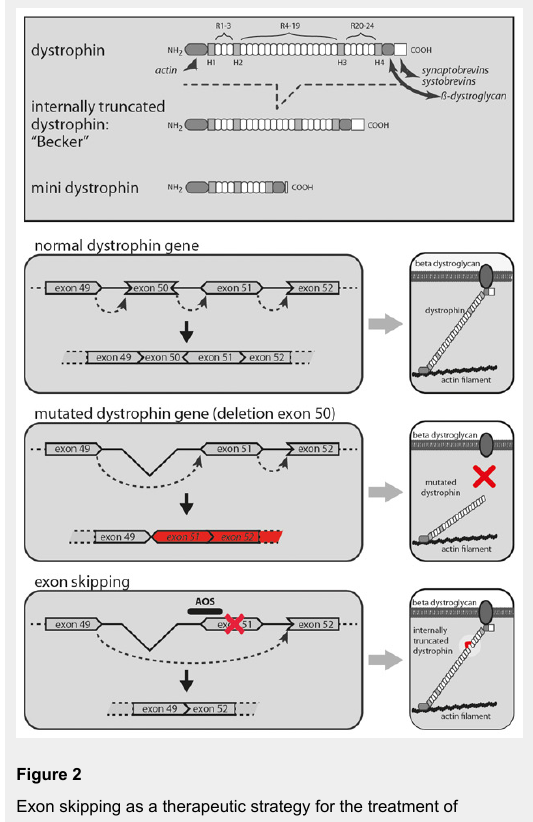
Exon skipping as a therapeutic strategy for the treatment of Duchenne muscular dystrophy. During splicing of the dystrophin pre-mRNA the introns are removed and exons are joined to build mRNA with a reading frame to allow synthesis of functional dystrophin proteins. In the case of exonic deletions, “out of frame” mRNA can be produced, inducing premature termination of protein translation. This leads to a nonfunctional dystrophin protein, rapidly removed by the cellular degradation machinery. An exon skipping strategy is applied to restore the reading frame. By use of antisense oligonucleotides targeting splice sites of the pre-mRNA, one or more exons are removed to correct the reading frame. This results in a shortened but partially functional dystrophin protein.